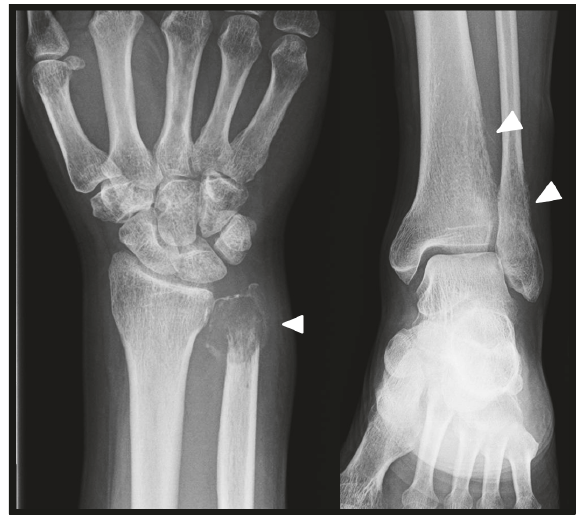
Figure 2: Plain radiographs of right distal ulna and the left lower leg show irregular osteolysis.